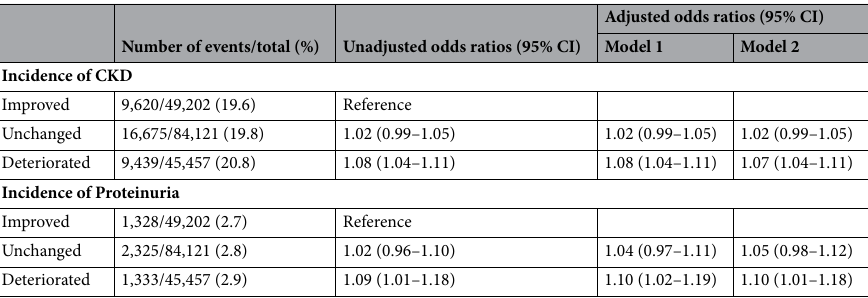
Table 3. Logistic regression models for the association between stage of change and incidence of CKD, proteinuria. CKD chronic kidney